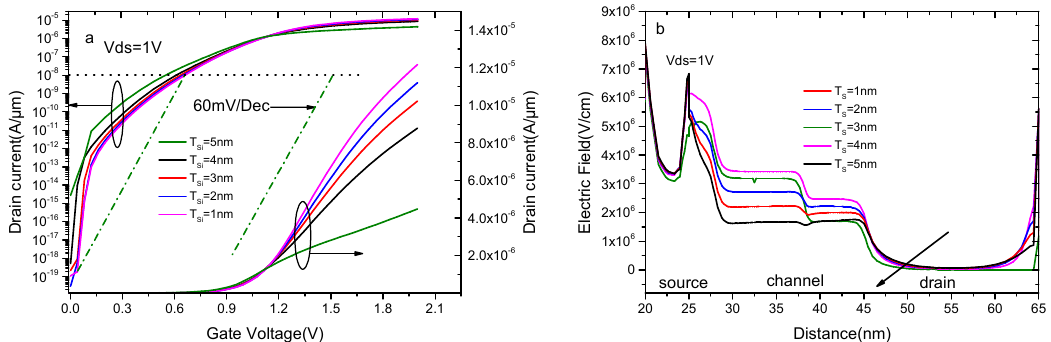
Figure 10. ( a ) Simulated log scale and linear scale transfer characteristics of DMMG-HJLTFET with different thickness of silicon (T S ) in sandwich stack structure (GaAs/Si/GaAs); ( b ) the distribution of electric field at the surface with different thickness of silicon (T S ) in sandwich stack structure (GaAs/Si/GaAs).